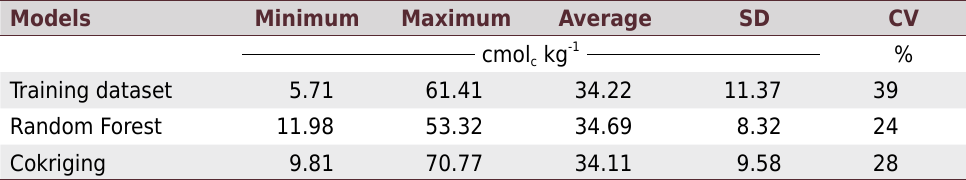
Table 4. Descriptive statistics from soil samples, Random Forest, and Cokriging models